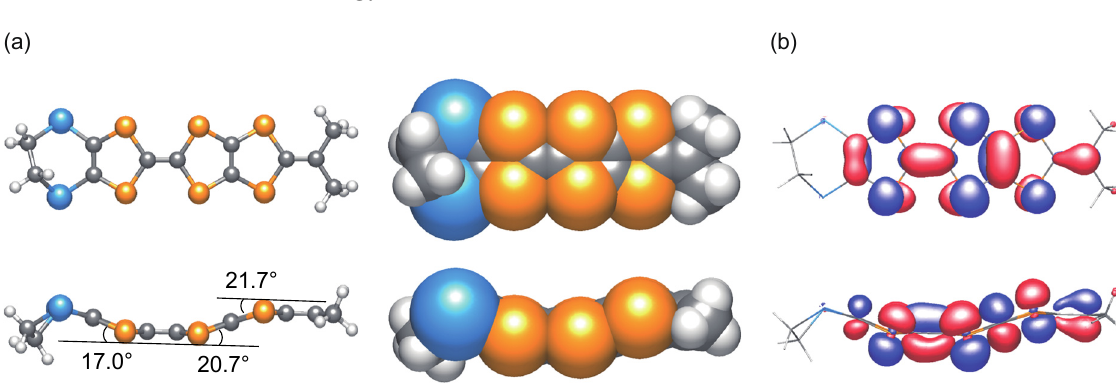
Figure 3. ( a ) Top view and side view of optimized structure of MeDTES are represented by a ball and stick model (left) and a space-filling model (right); ( b ) The HOMO of MeDTES, of which the energy level is − 4.72 eV.